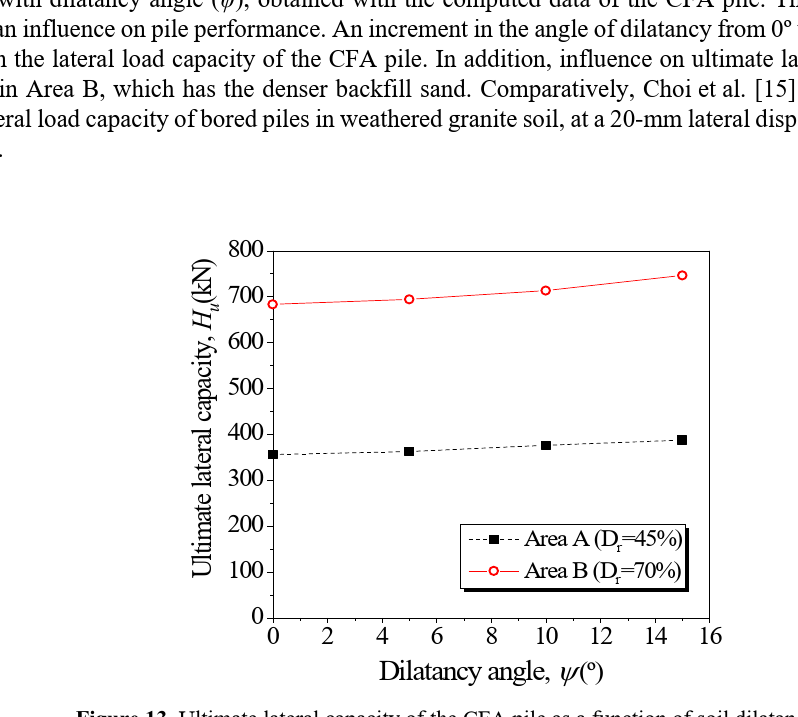
Figure 13. Ultimate lateral capacity of the CFA pile as a function of soil